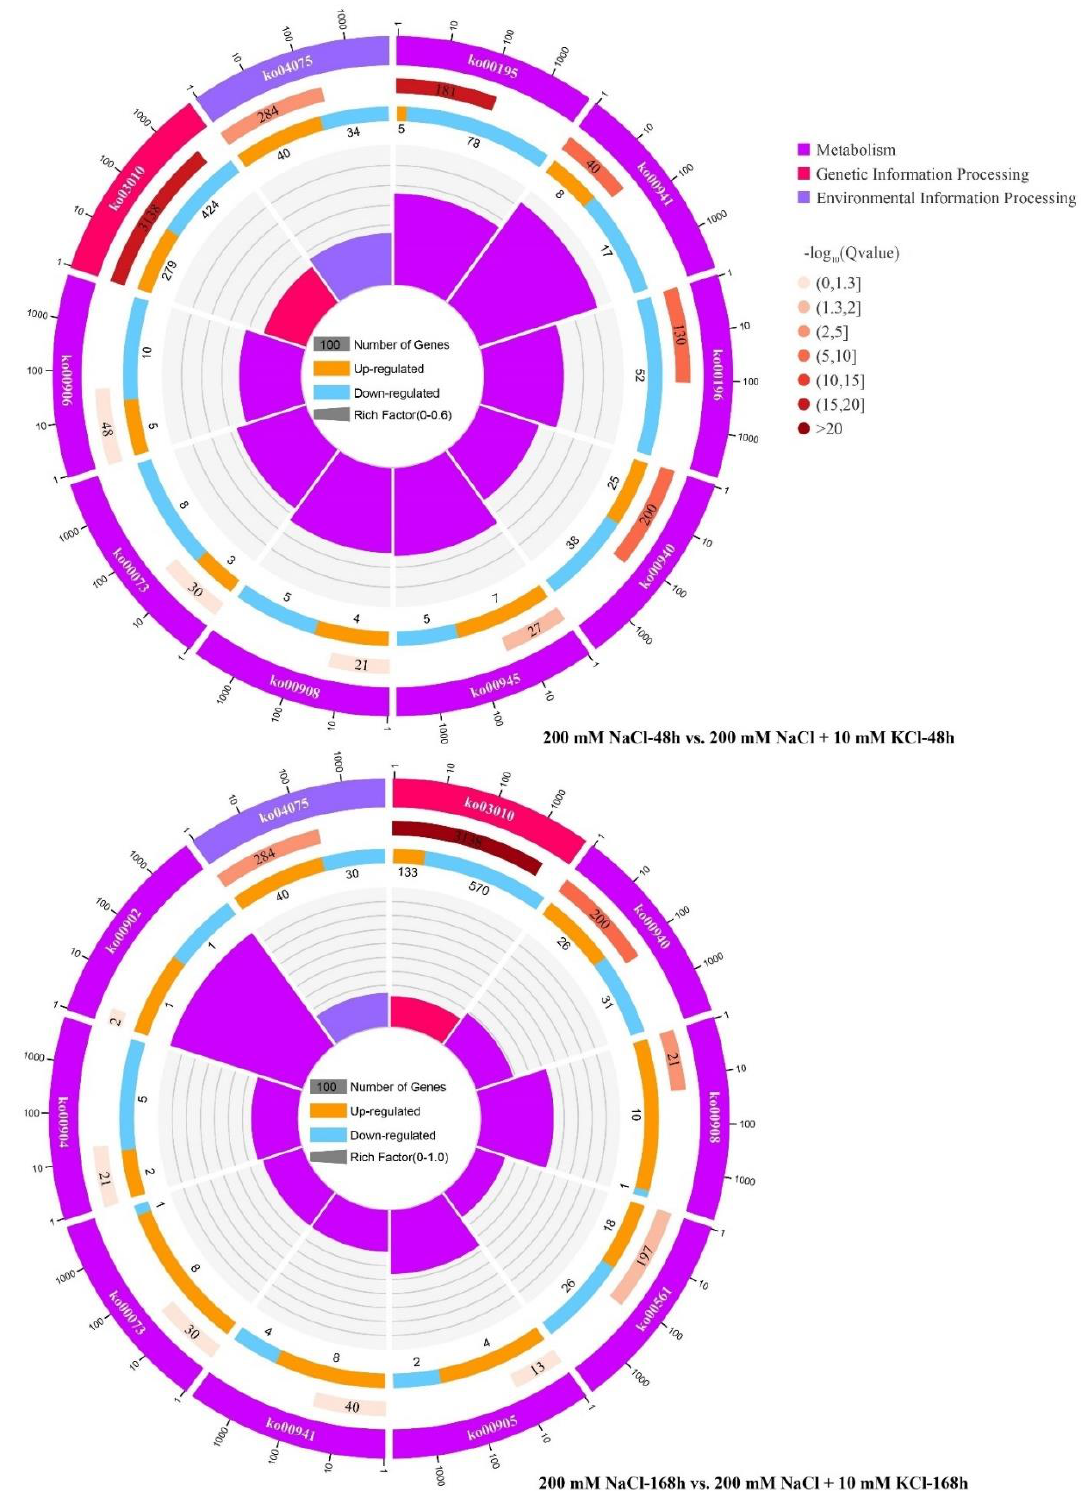
Figure 1. Top 10 KEGG pathway analysis. (KEGG pathway analysis of the top 10 enrichment of the root of T. ramosissima under NaCl stress for 48 h and 168 h with exogenous potassium. The first and outer circles show the top 20 KEGG pathways enriched, while the scale outside the circle indicates the number of genes. Different colours represent different ontologies. Next, the KEGG pathway number in the background gene along with the Q value can be seen in the second circle. A darker colour indicates a lower Q value, and a lighter colour indicates a higher Q value. Longer bars indi- cate more genes. Dark colours indicate genes that are upregulated, and light colours indicate genes that are downregulated. Below is a display of the specific value. Last and inner circle: rich factor